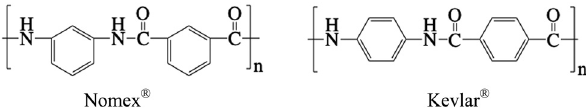
Figure 1: Structures of the aromatic PAs, Nomex, and